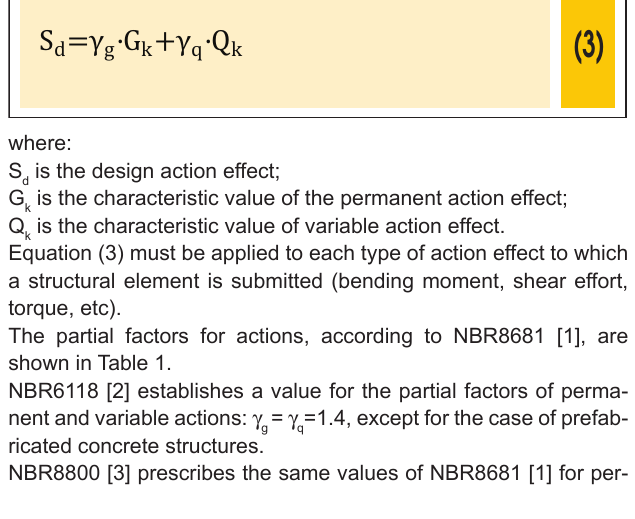
Figure 1 – Rectangular cross-section of reinforced concrete with simple